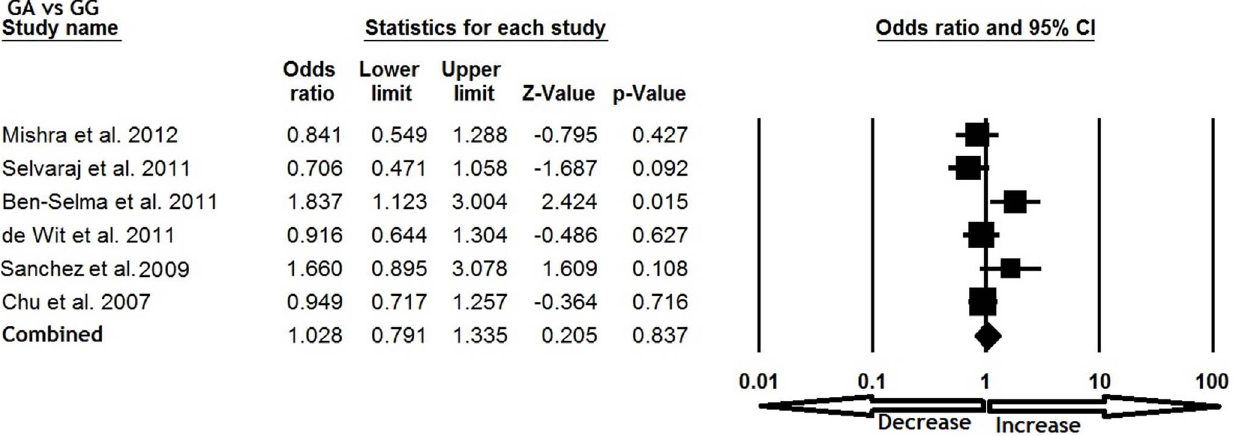
Figure 4. Forest plot and ORs with 95% CI of CCL5 -403G . A polymorphism and TB risk (GA vs. GG).